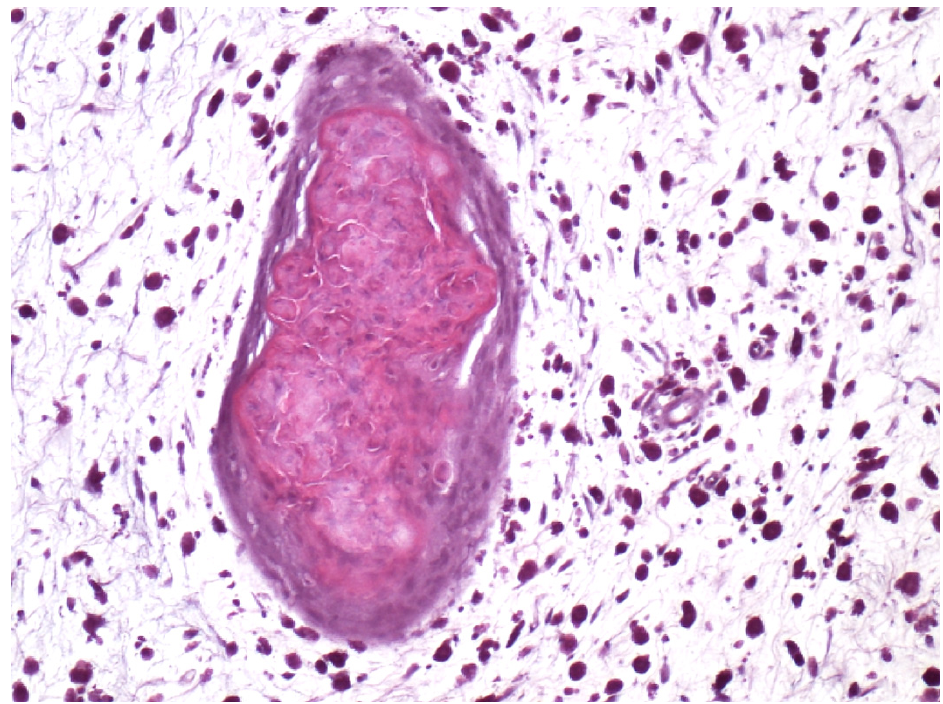
Figure 2. Small granuloma in loose connective tissue with scattered leukocytes. No specific cause was identified.